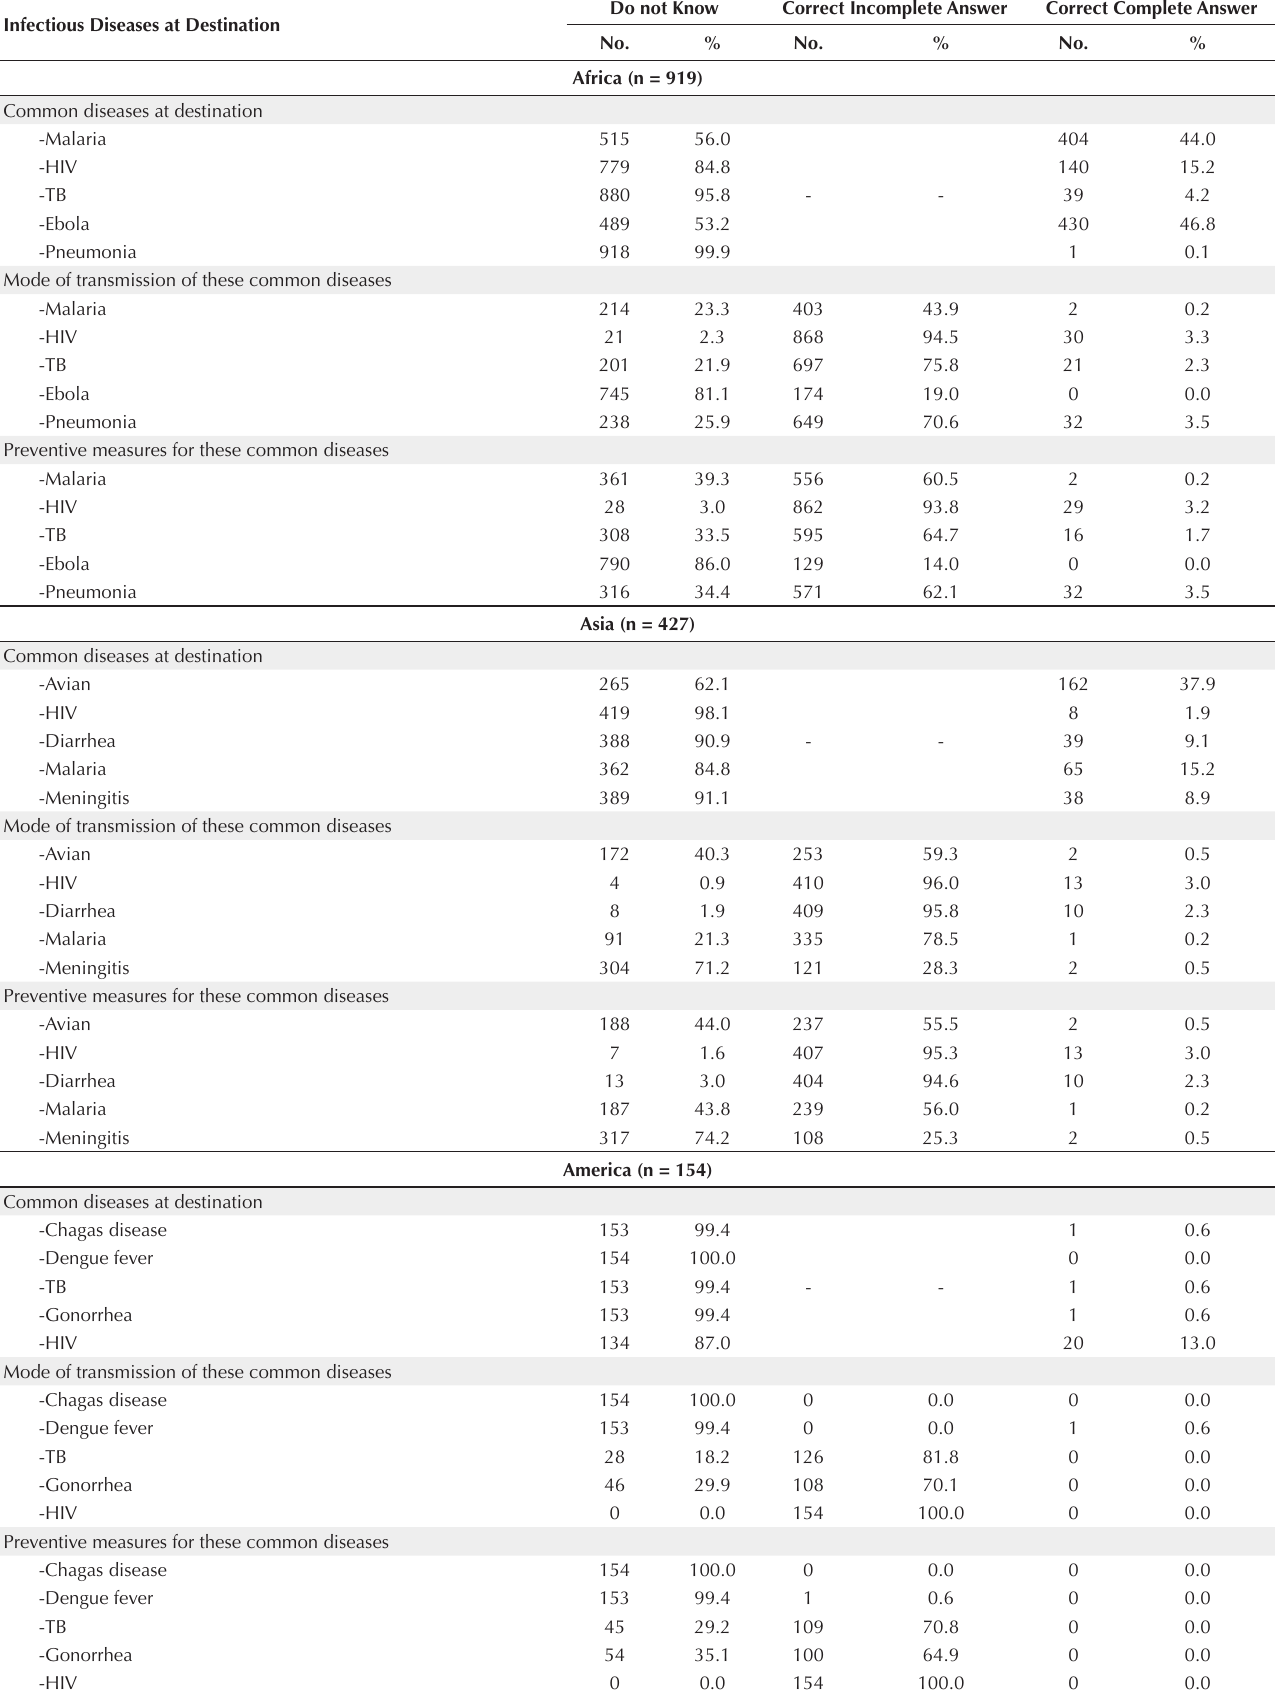
Table 1. Distribution of Travelers at Cairo International Airport According to Knowledge About Infectious Diseases at Destinations Infectious Diseases at Destination